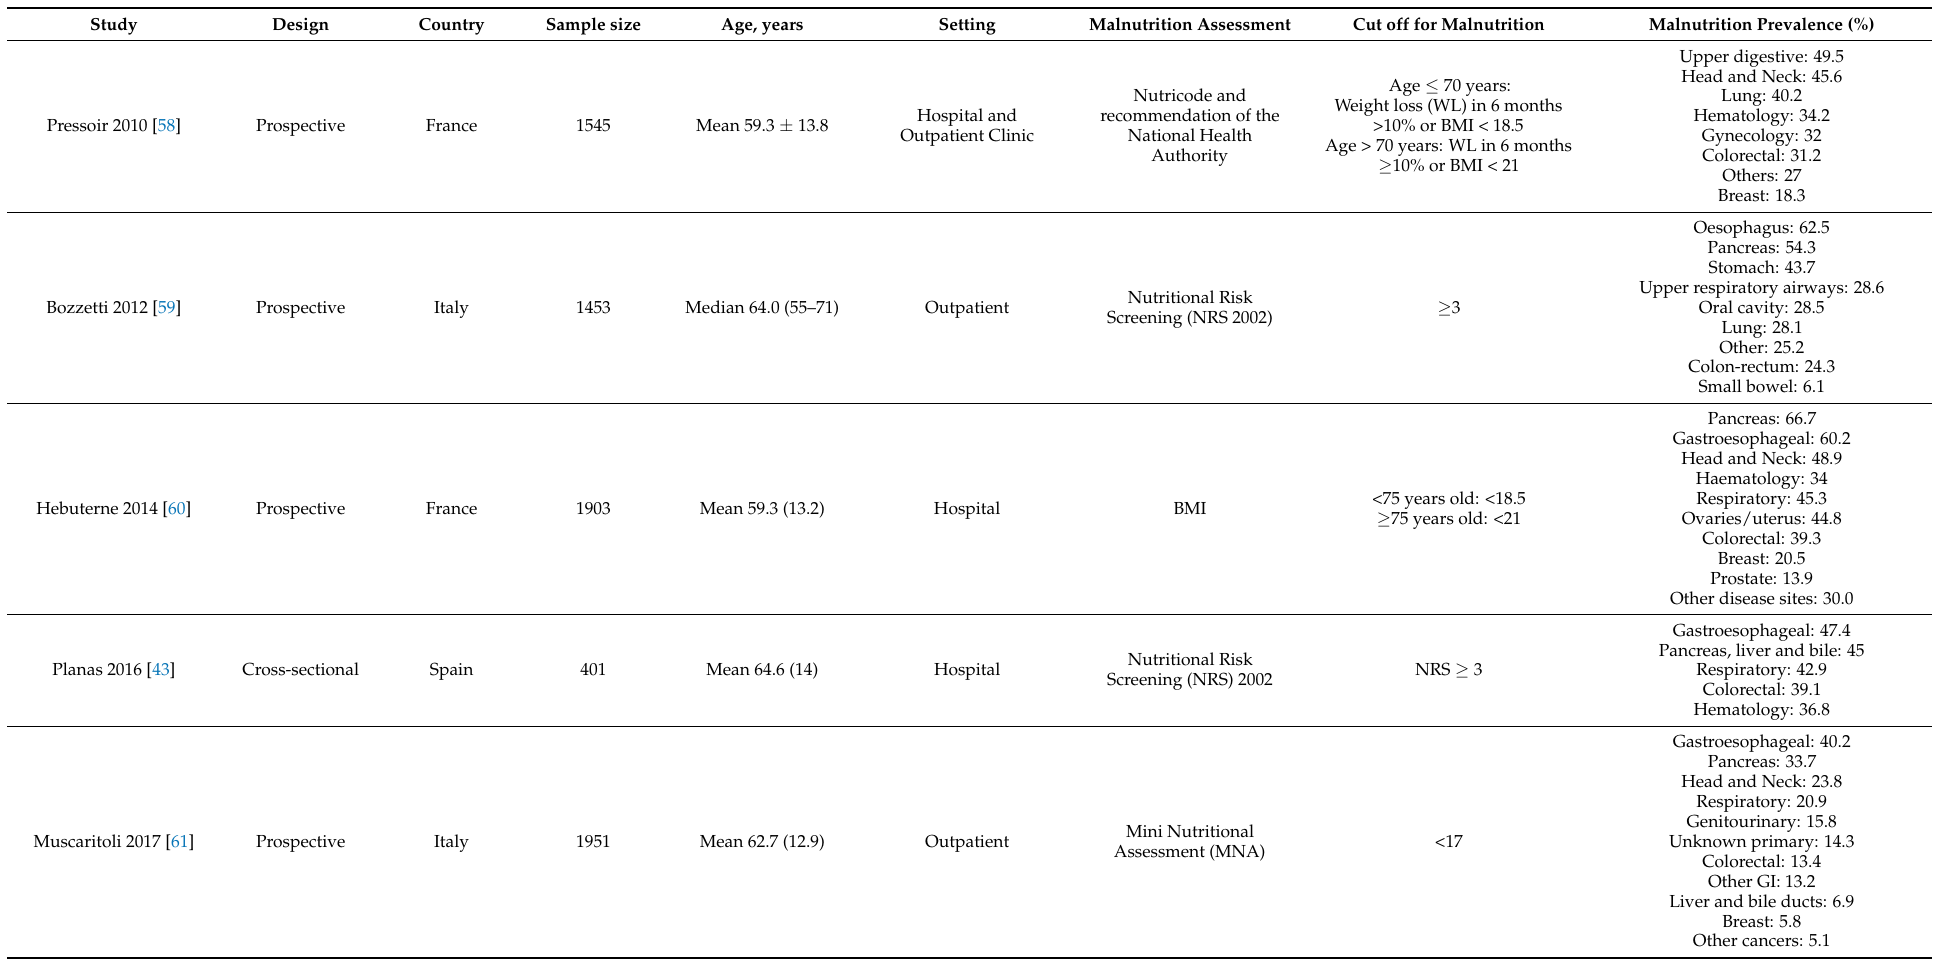
Table 4. Summary of studies assessing the prevalence of malnutrition in cancer (any type) according to the tumor